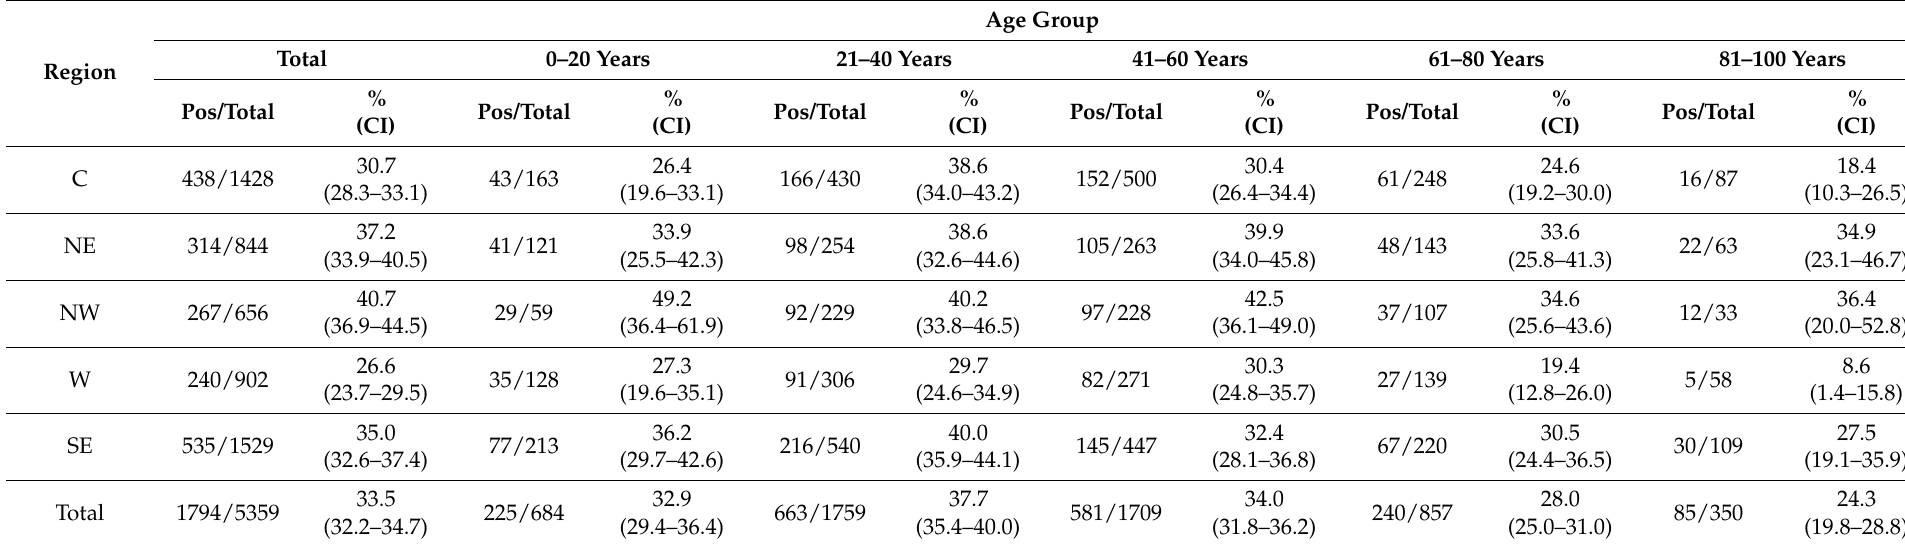
Table 1. Seroprevalence of IgG antibodies